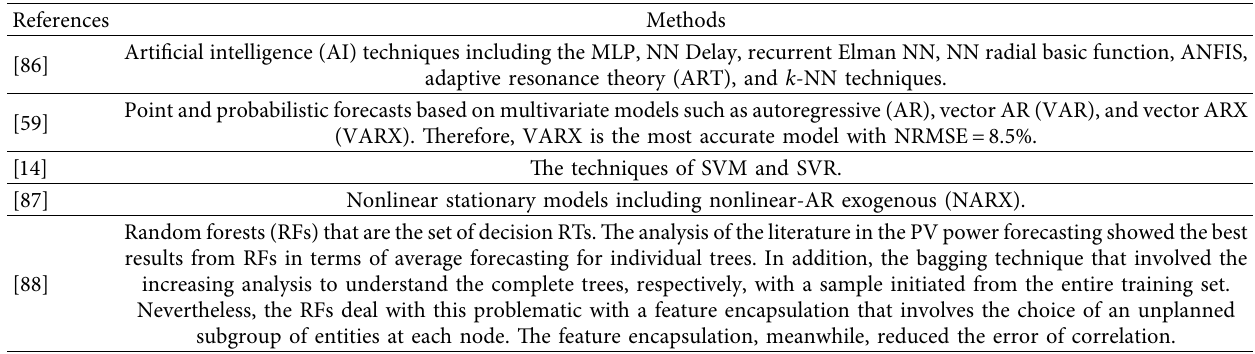
Table 6: The most popular regressive models in the